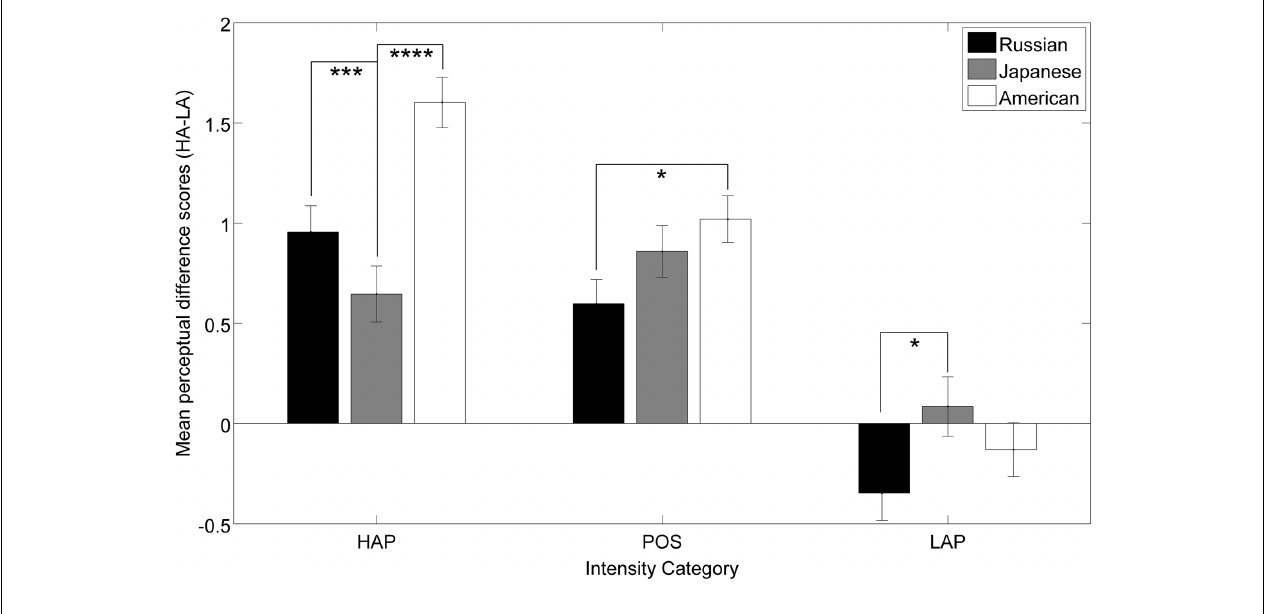
In the POS intensity category, American participants differentiated between high and LA images to a significantly greater extent than Russian, but not Japanese participants. Finally, Russian participants perceived LA facial expressions as significantly lower arousal (LAP) compared to Japanese participants. **** = p < 0.001; *** = p < 0.005; ** = p < 0.01; * = p <